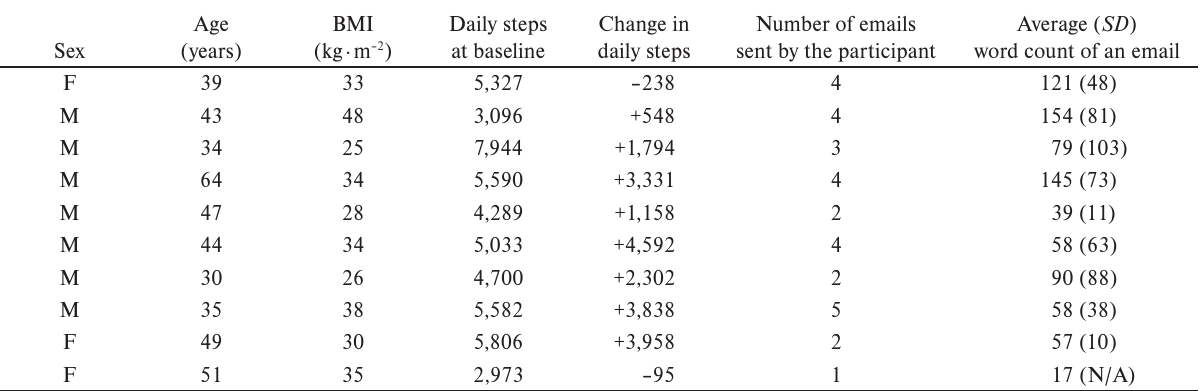
Characteristics of individual participants